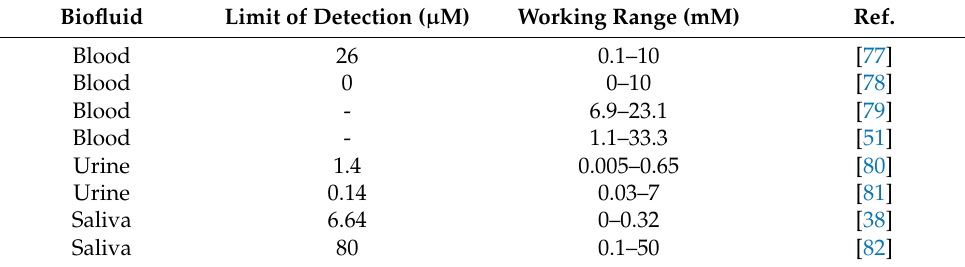
Table 3. List of smartphone-based portable glucose monitoring systems.